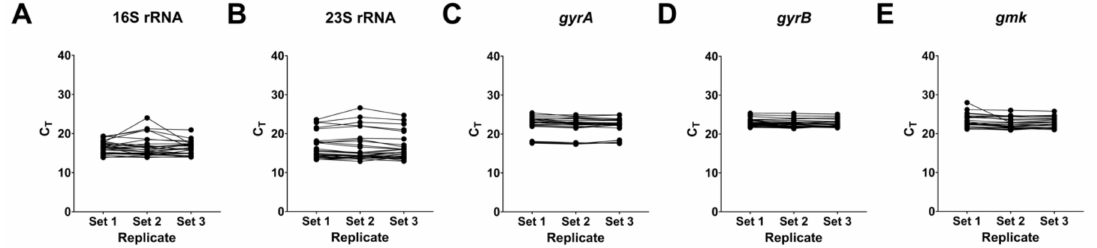
Figure 6. Distribution of C T values of some commonly used “housekeeping” genes. Relative qPCR assay signal levels of ( A ) 16S rRNA, ( B ) 23S rRNA, ( C ) gyrA , ( D ) gyrB and ( E ) gmk in S. aureus ATCC ® 25923, 29213 and MRSA strain USA300. Data irrespective of strains or treatment groups were all plotted together as y -values and segregated by their corresponding replicate sets on the x -axis. Experiments were performed in